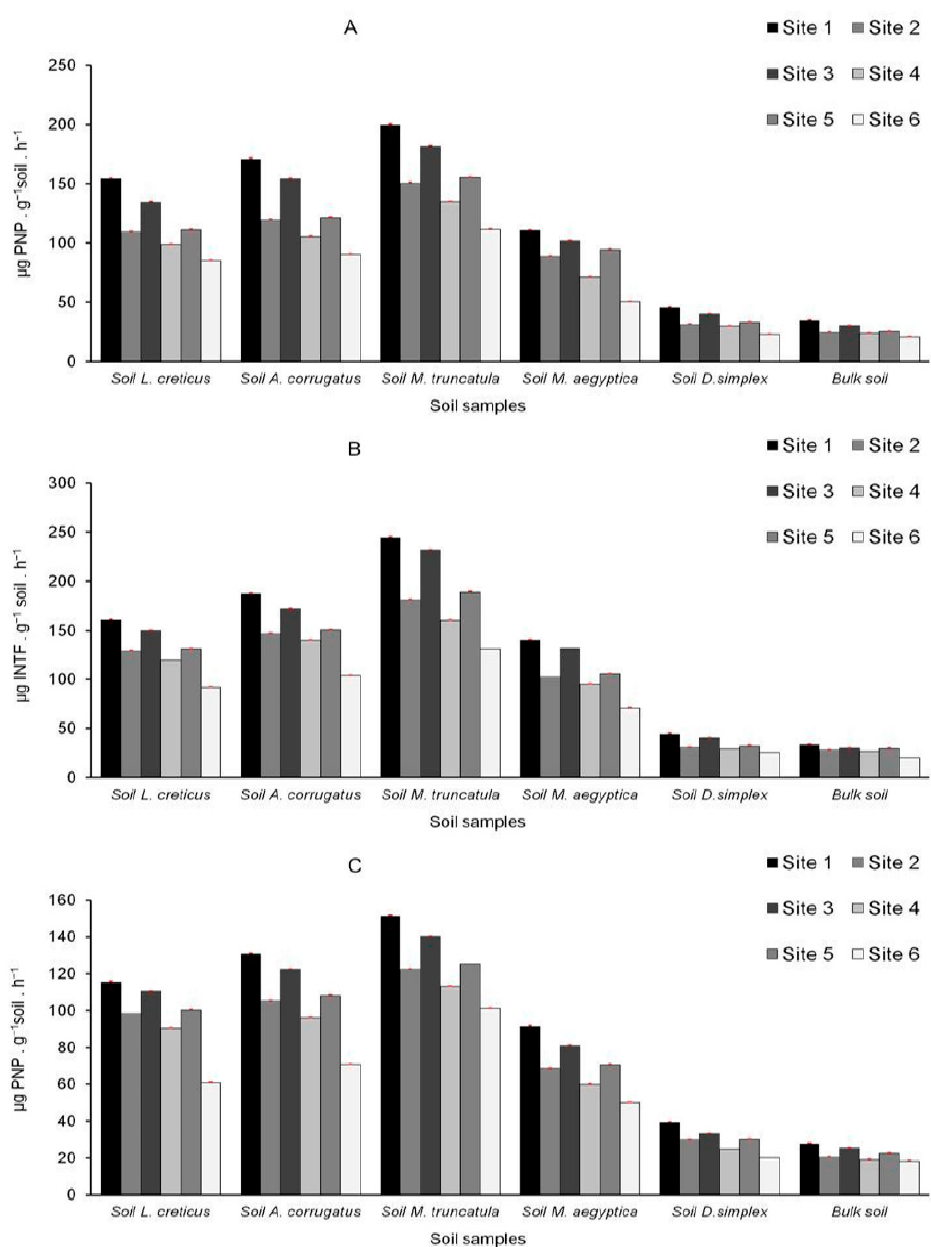
Figure 7. Phosphatase ( A ), dehydrogenase ( B ), β -glucosidase ( C ) activities in the studied soils. PNP: p nitrophenol, INTF: iodonitrotetrazolium formazan. Data are reported as mean ( ± SE) of three replicates per sample.